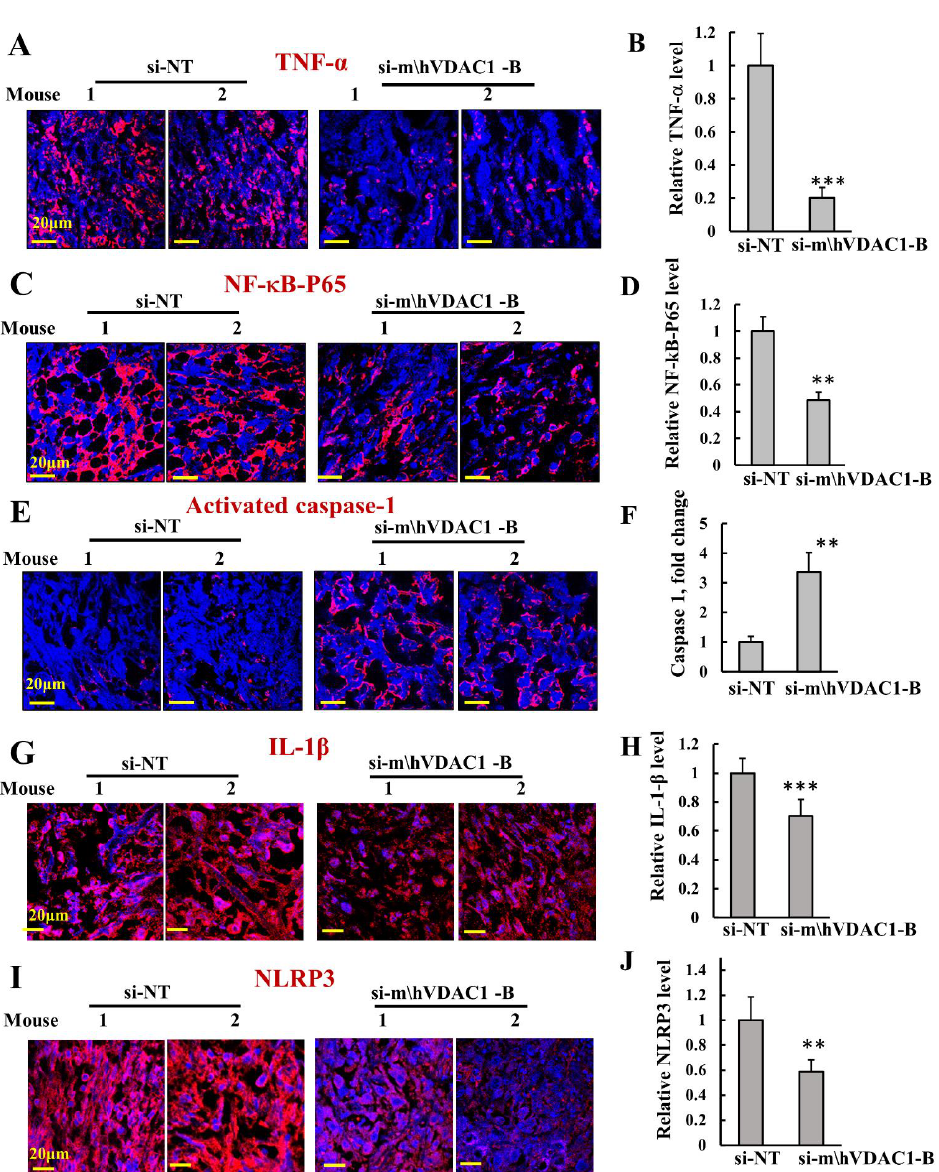
Figure 7. Silencing VDAC1 expression in the tumors altered inflammation. Representative im- munofluorescence images of sections from si-m/hVDAC1-B-treated or si-NT-treated H226-cell- derived tumors stained and quantified for TNF- α ( A , B ), NF-kB-p65 ( C , D ), cleaved caspase-1 ( E , F ), IL-1 β ( G , H ), and NRLP3 ( I , J ). Results represent the means ± SEM (n = 3) ** p ≤ 0.01; *** p ≤ 0.001. Inflammation also involves activation of pro-capsase-1 via NRLP3 inflammasome as- sembly, leading to the activation of pro-inflammatory molecules such as IL-1 β , IL-18, FGF2, and IL-1 β . Therefore, we tested the effects of si-m/hVDAC1-B tumor treatment on the ex- pression of NRLP3, activated caspase 1, and IL-1 β (Figure 7E–J). si-m/hVDAC1-B-treated tumors showed an over 3-fold increase in activated capsase-1 levels (Figure 7E,F). On the other hand, the levels of IL-1 β and NRLP3 were reduced in the si-m/hVDAC1-B-treated tumors (Figure 7G–J). This may suggest that activated caspase-1 is associated with the initiation of inflammatory programmed cell death (pyroptosis) and, in turn, inhibits tumor growth rather than upregulating pro-inflammatory molecules such as IL-1 β and IL-18